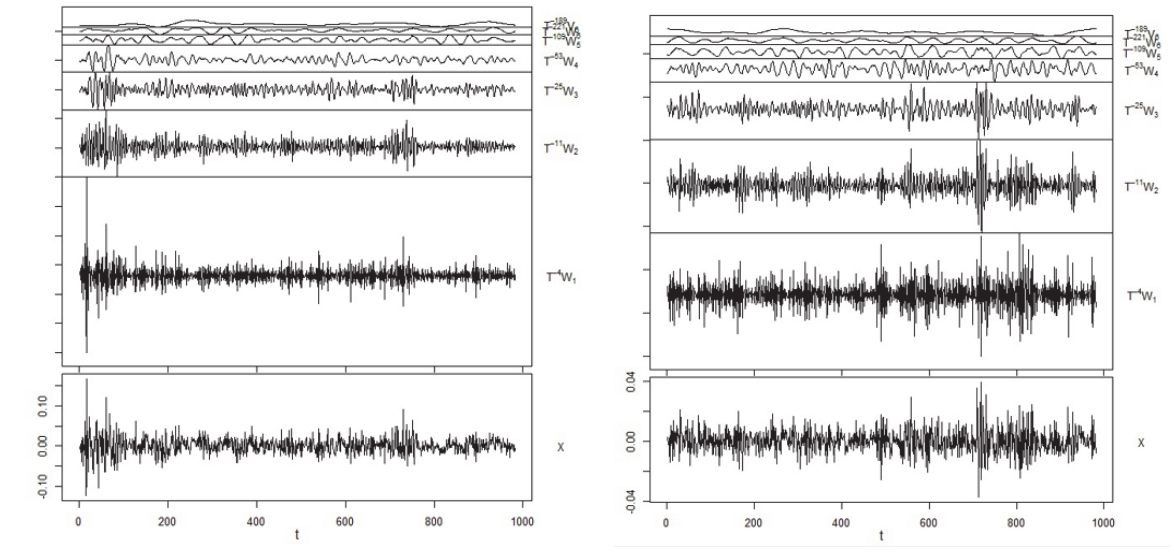
Fig. 1. MODWT Decomposition of CRUDEOIL Fig. 2. MODWT Decomposition of DJIA